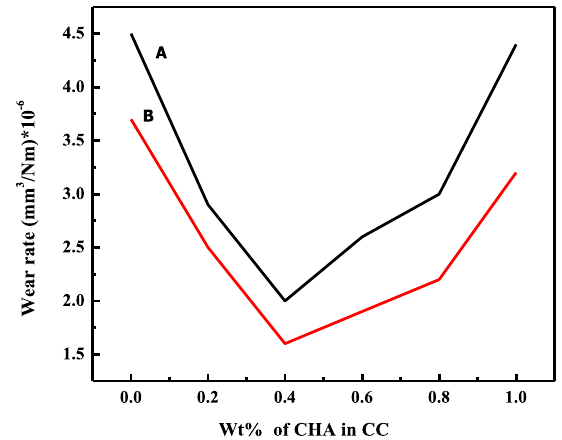
Fig. 8 Wear rate of CC during wear experiment conducted at 2 N applied load and 300 m sliding distance at room temperature in A dry and B wet